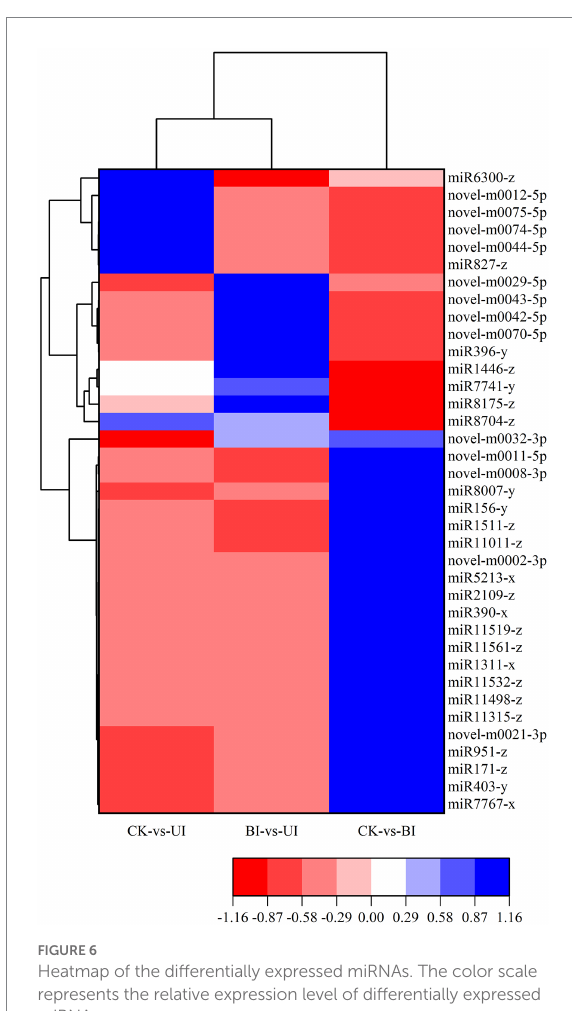
FIGURE 6 Heatmap of the differentially expressed miRNAs. The color scale represents the relative expression level of differentially expressed